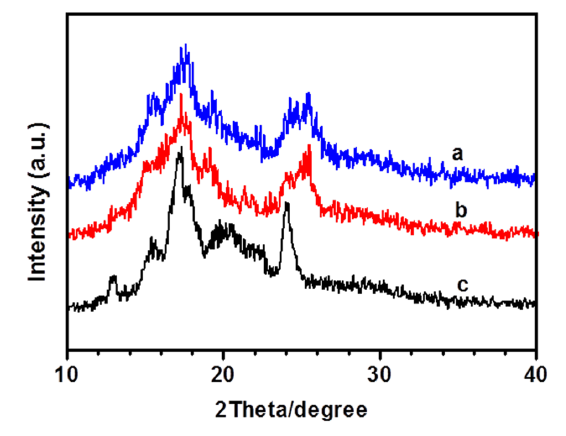
Figure 5: FTIR spectra of gels : (a) powder, (b–d) ethanol, isopropanol and 1-butanol xerogels, respectively.